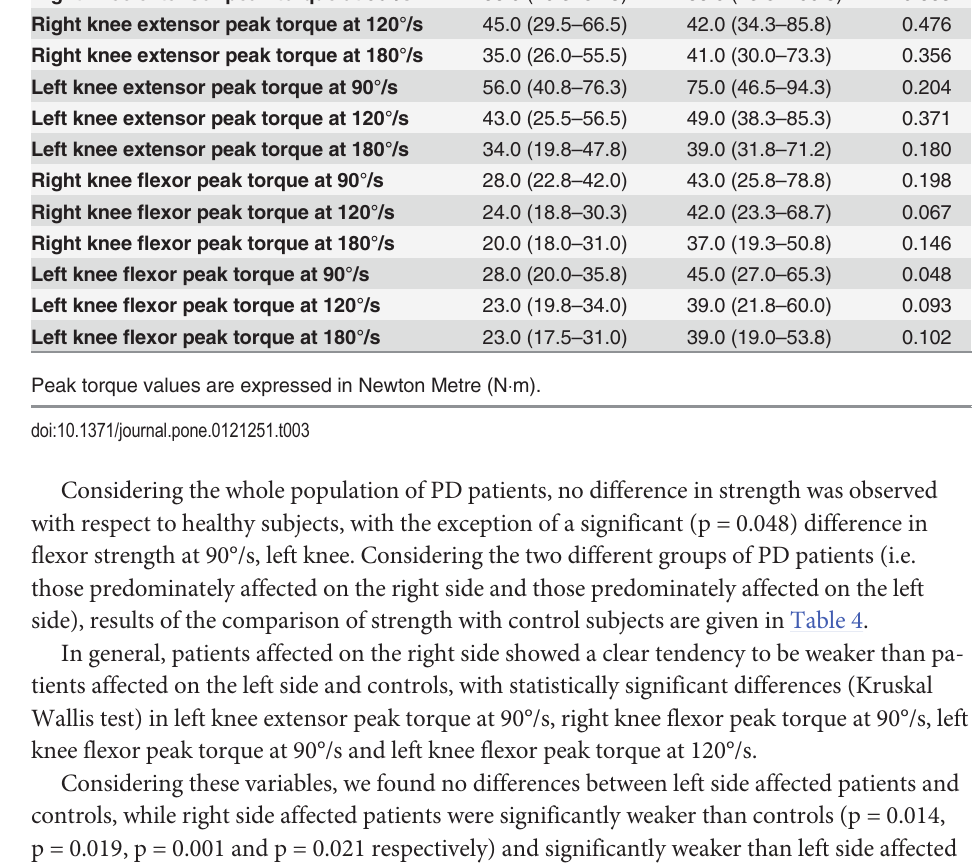
Table 4. Extensor and flexor strength (peak torque) at 90°/s, 120°/s and 180°/s in PD patients predominately affected on the left and on the right side (Left PD and Right PD, respectively), and controls. Variable Right knee extensor peak torque at